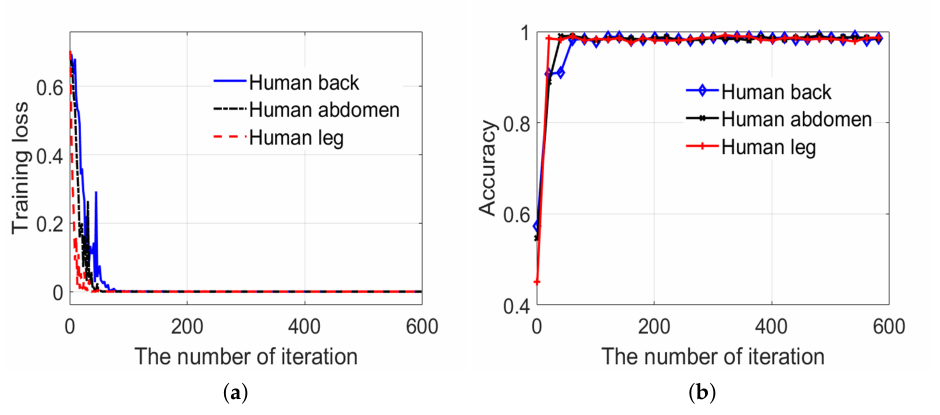
Figure 10. Variation of training loss and testing accuracy in the training process of sub-network 2. ( a ) training loss in the training process. ( b ) testing accuracy in the training